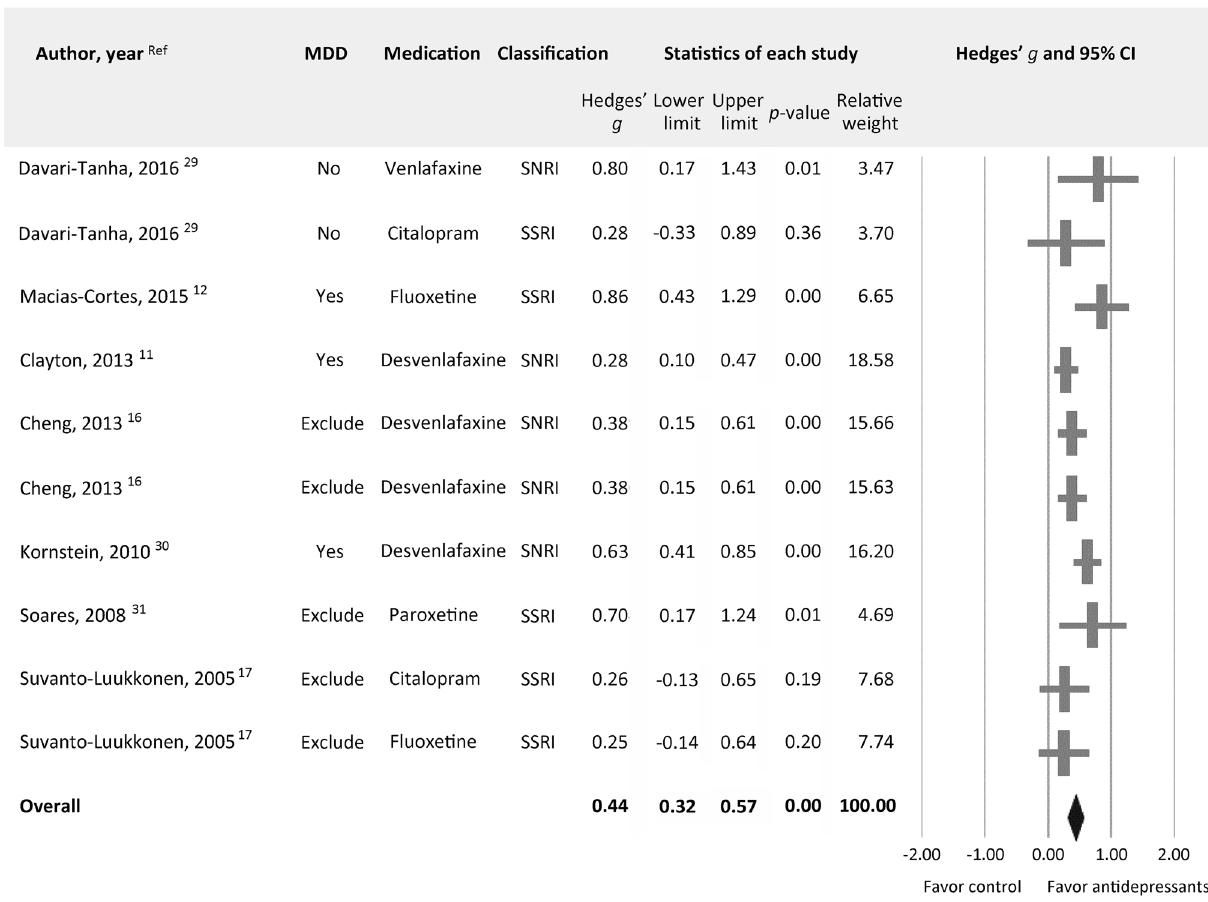
Figure 2. Forest plot of changes in depressive symptoms in menopausal women with antidepressant treatments compared to those without. Note significantly better improvements in severity of depressive symptoms (k = 10, Hedges’ g = 0.44, 95% CI 0.32 to 0.57, p < 0.001) in subjects receiving antidepressants compared to that in